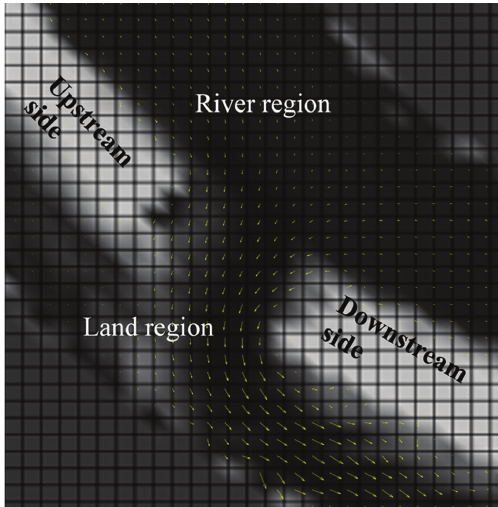
Figure 8. Flow field of case 2 ( B = 40cm)